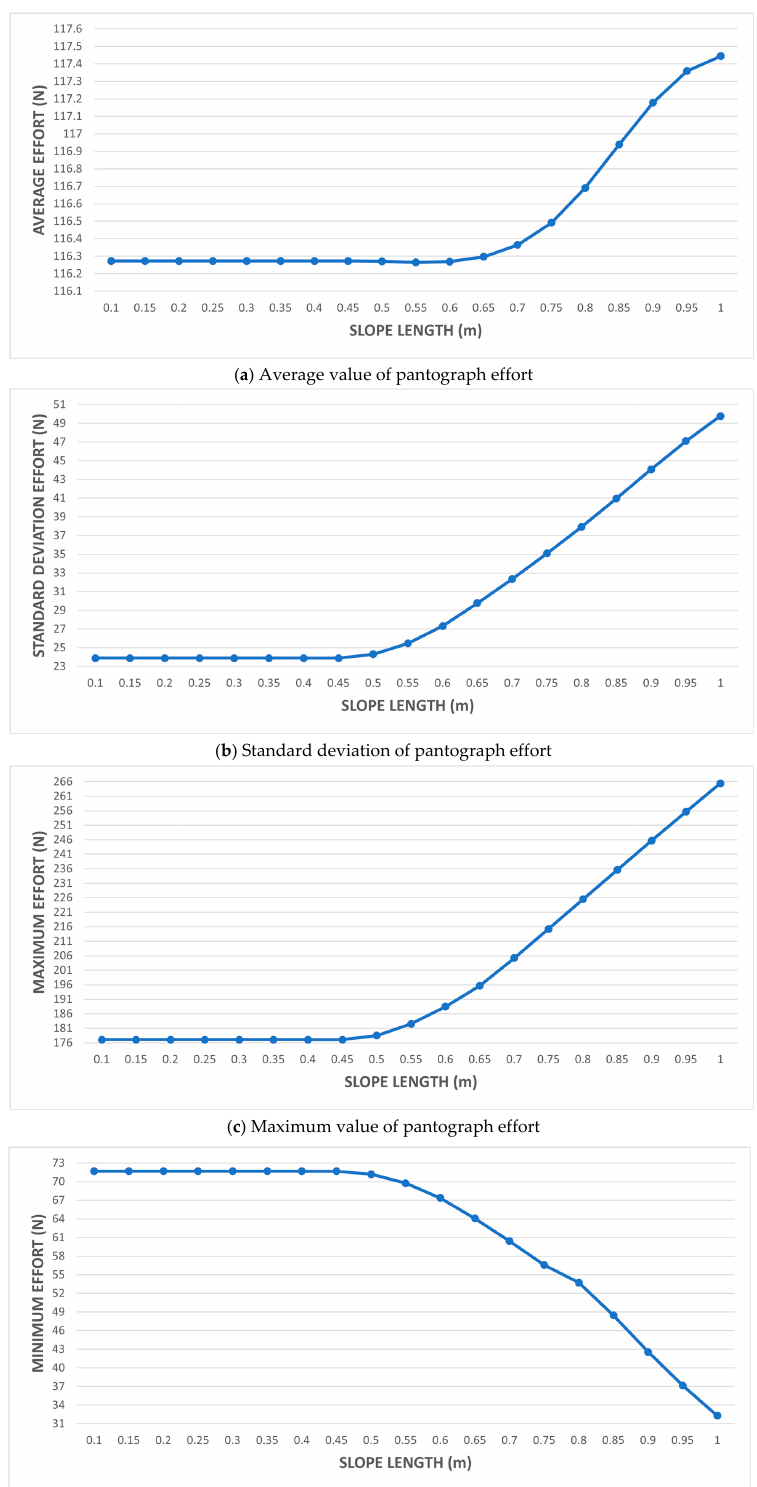
Figure 11. Graphs of simulation 2. Overlapping span of 1 m variation in slope length in the range of 0.5 to 1 m with 0.05 m increments and 0.1 m slope elevation. ( a ) Average value of pantograph effort, ( b ) standard deviation of pantograph effort, ( c ) maximum value of pantograph effort, and ( d ) minimum value of pantograph effort.